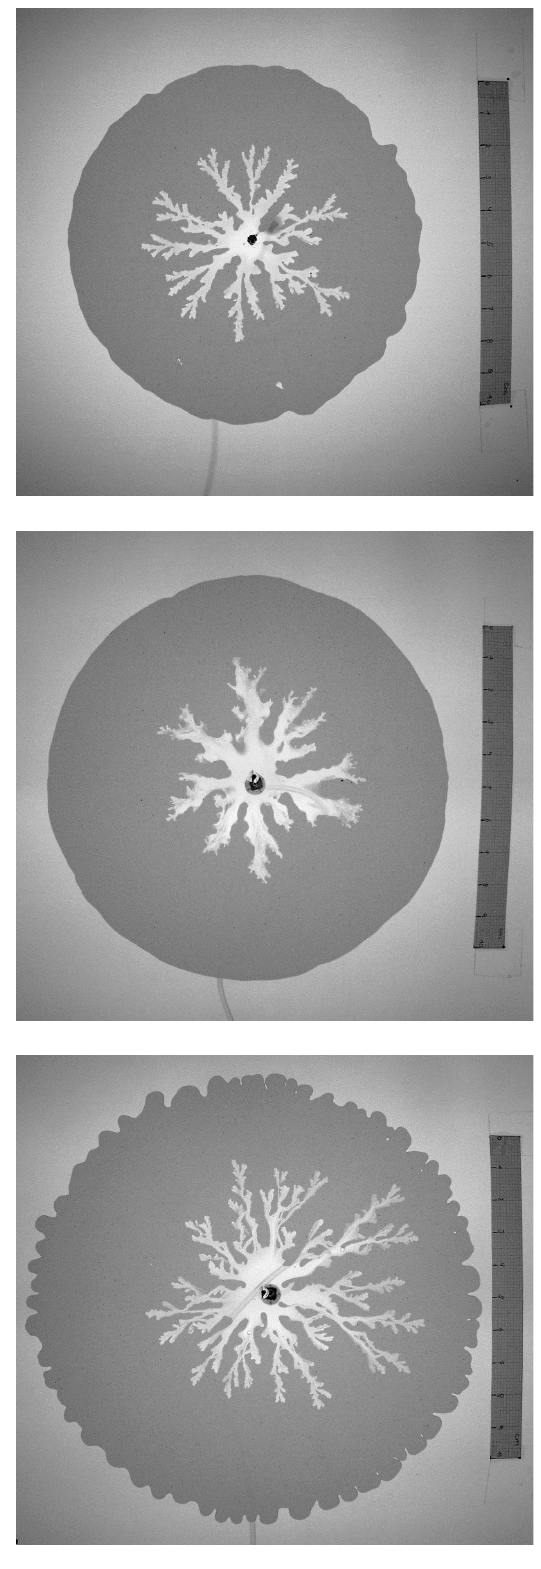
Figure 4: Binary image of a pattern formed with dis- tilled water as injection fluid. It contains a branch network of the digital image